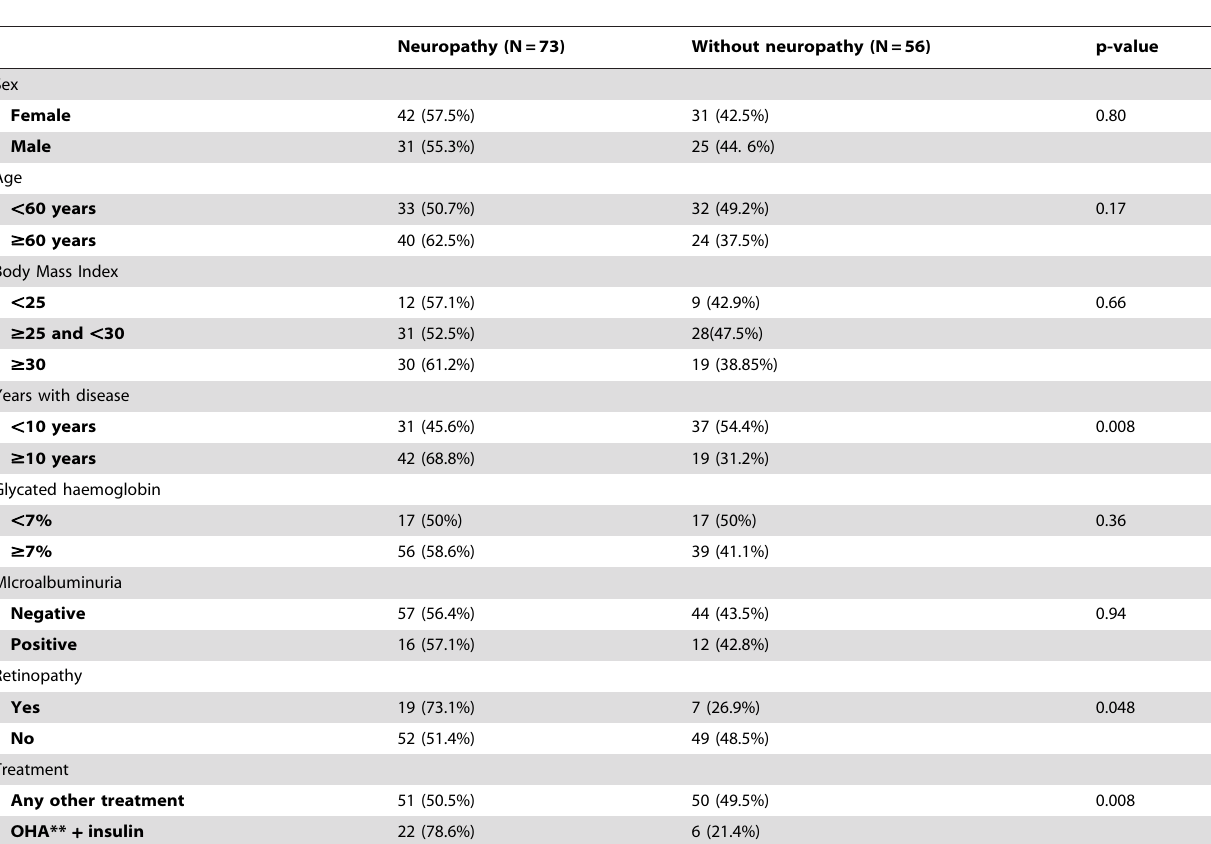
Table 1. Characteristics of the study population according to neuropathy.